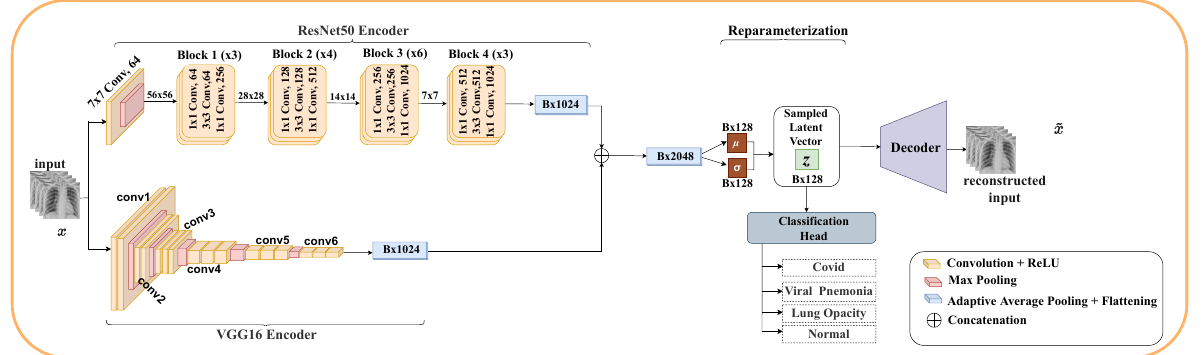
Figure 2. Model One: This architecture has two encoders and a single decoder. The feature maps of the last layers of both encoders are concatenated to give a richer feature map before reparameterization is done to sample the latent embedding z